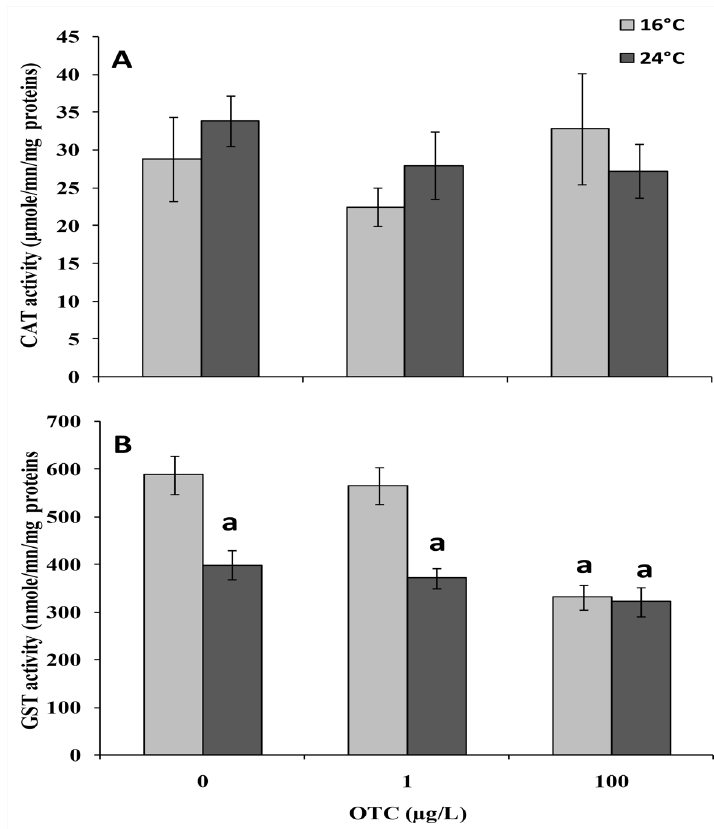
Fig 3. Catalase (CAT; A) and glutathione S-transferase (GST; B) activity in gills of mussels after a 4-day treatment with 1 or 100 μ g/L oxytetracycline at 16° and 24°C. Data are expressed as μ mole/mn/mg proteins and represent the mean ± Sd (N = 4). a: significantly different from reference condition. b: significantly different from OTC-untreated mussels at 24°C (p < 0.05).